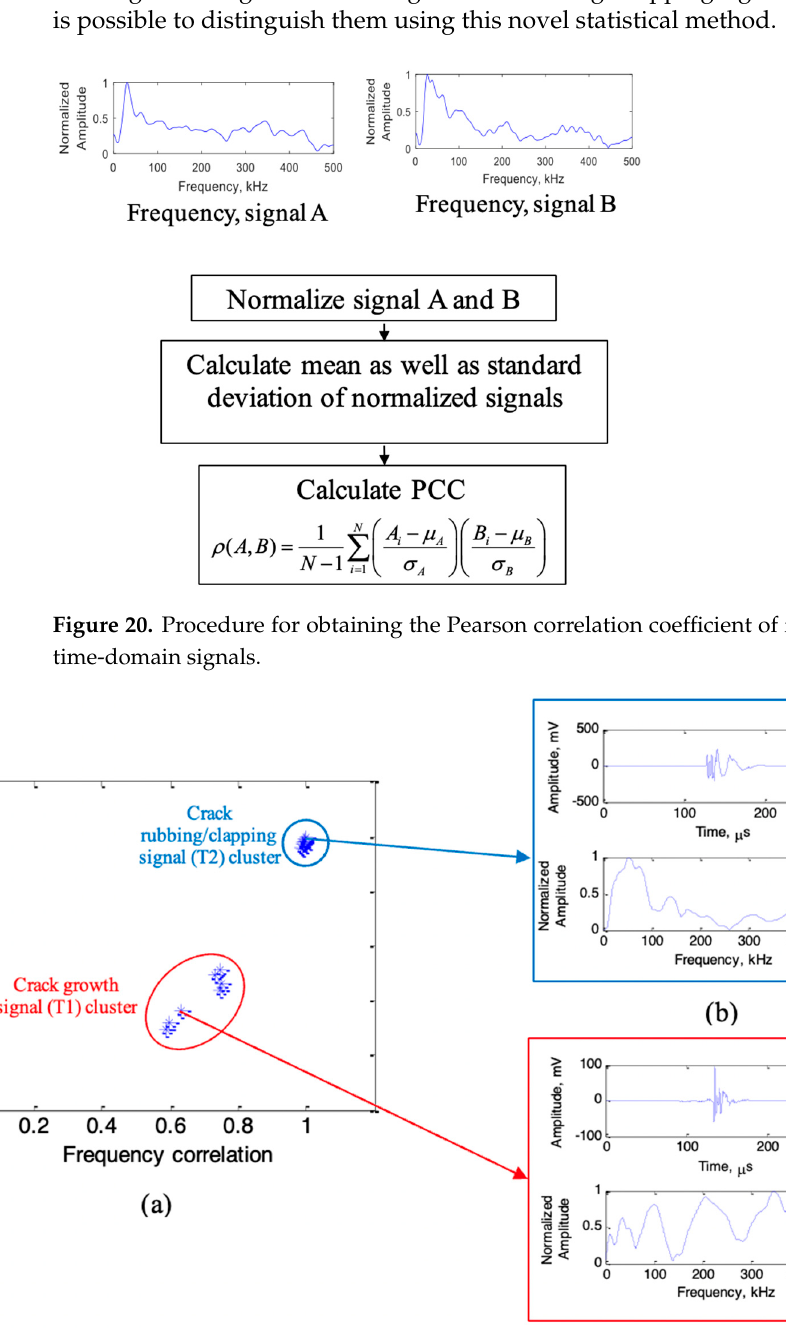
Figure 19. Procedure for obtaining the Pearson correlation coefficient of two time − domain signals.